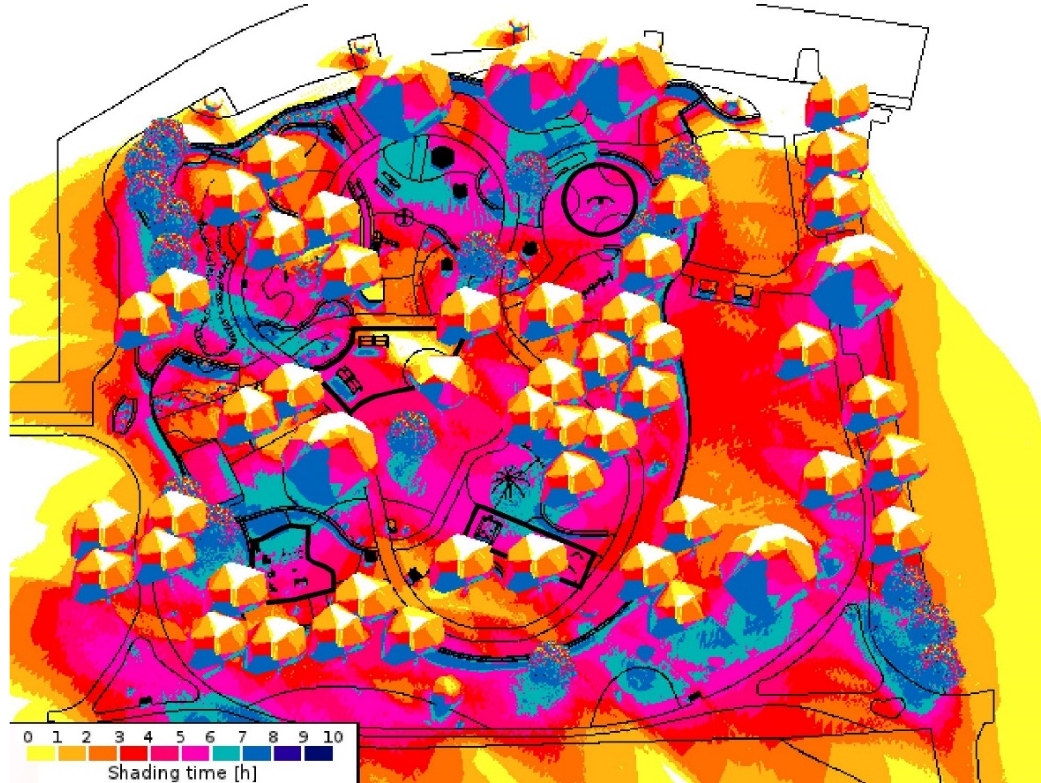
Figure 14. Winter solstice: 21 June (ten total daylight hours per day).